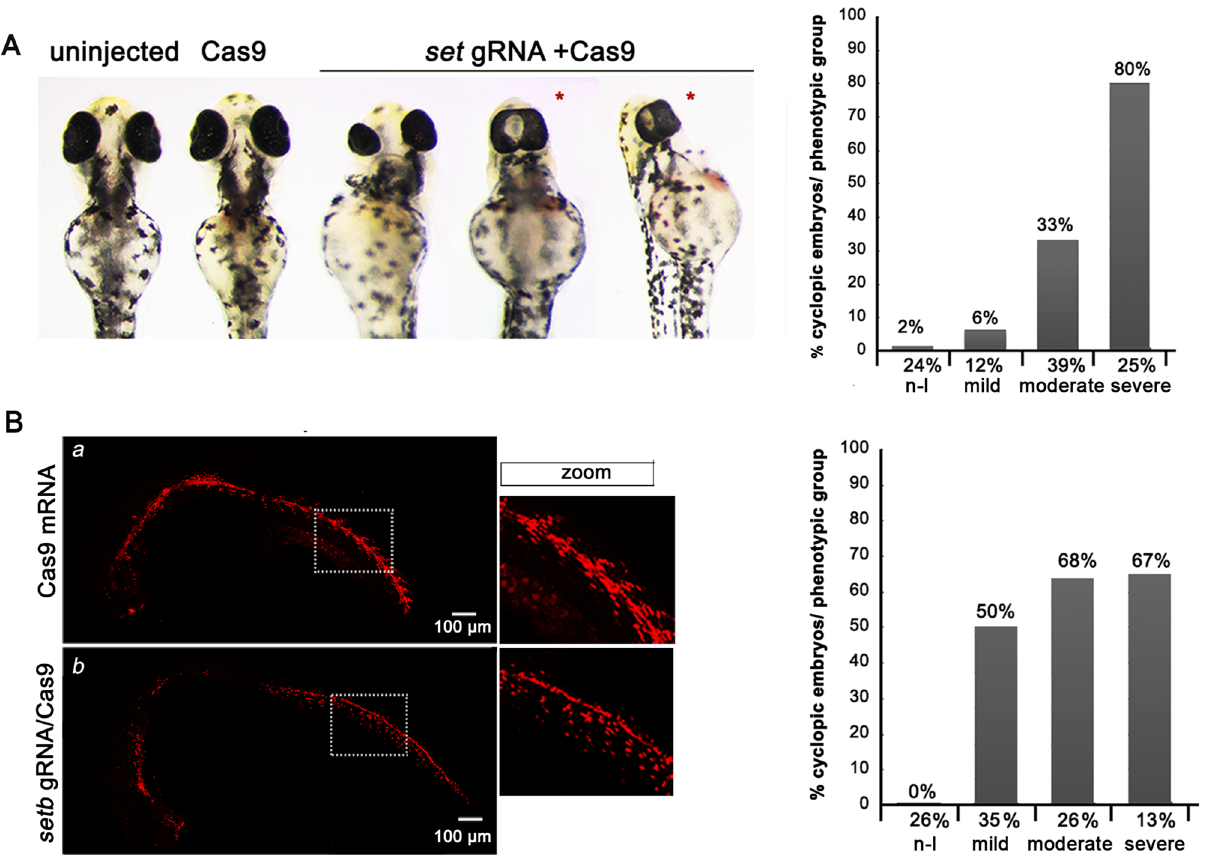
Figure 1. Impact of targeting the setb gene on Hedgehog signaling in zebrafish embryos. ( A ) Zebrafish setb crispants exhibit cyclopia. One- to two-cell stage zebrafish embryos were injected with 4.6 nl of 150 ng/μl of Cas9 mRNA or with 50 ng/μl of setb gRNA and 150 ng/μl of Cas9 mRNA and were examined morphologically at 48 hpf. (Right graph). Phenotypic scoring of the injected embryos (n = 262, n denotes the number of injected embryos). Numbers in X-axis refer to percentage of embryos in each phenotypic group and numbers on the bars refer to the percentage of cyclopic embryos in each phenotypic group. ( B ) Hh signaling is reduced in Tg12x_Gli transgenic zebrafish embryos injected with setb gRNA/Cas9. One- to two-cell stage Tg12x_Gli transgenic zebrafish embryos were injected with setb gRNA/Cas9 and examined under a confocal fluorescence microscope at 24 hpf. The phenotypic scoring of the injected embryos is shown in the graph (n = 96). The squares show enlargement of the trunk areas that display decreased mCherry fluorescence intensity. Note the disrupted morphology of the somites in the marked